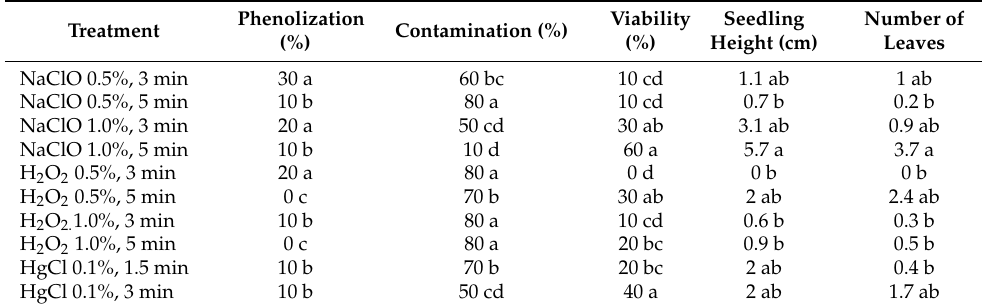
Table 2. Effect of different sterilization treatments on ‘Aroma’ strawberry meristems during in vitro establishment.